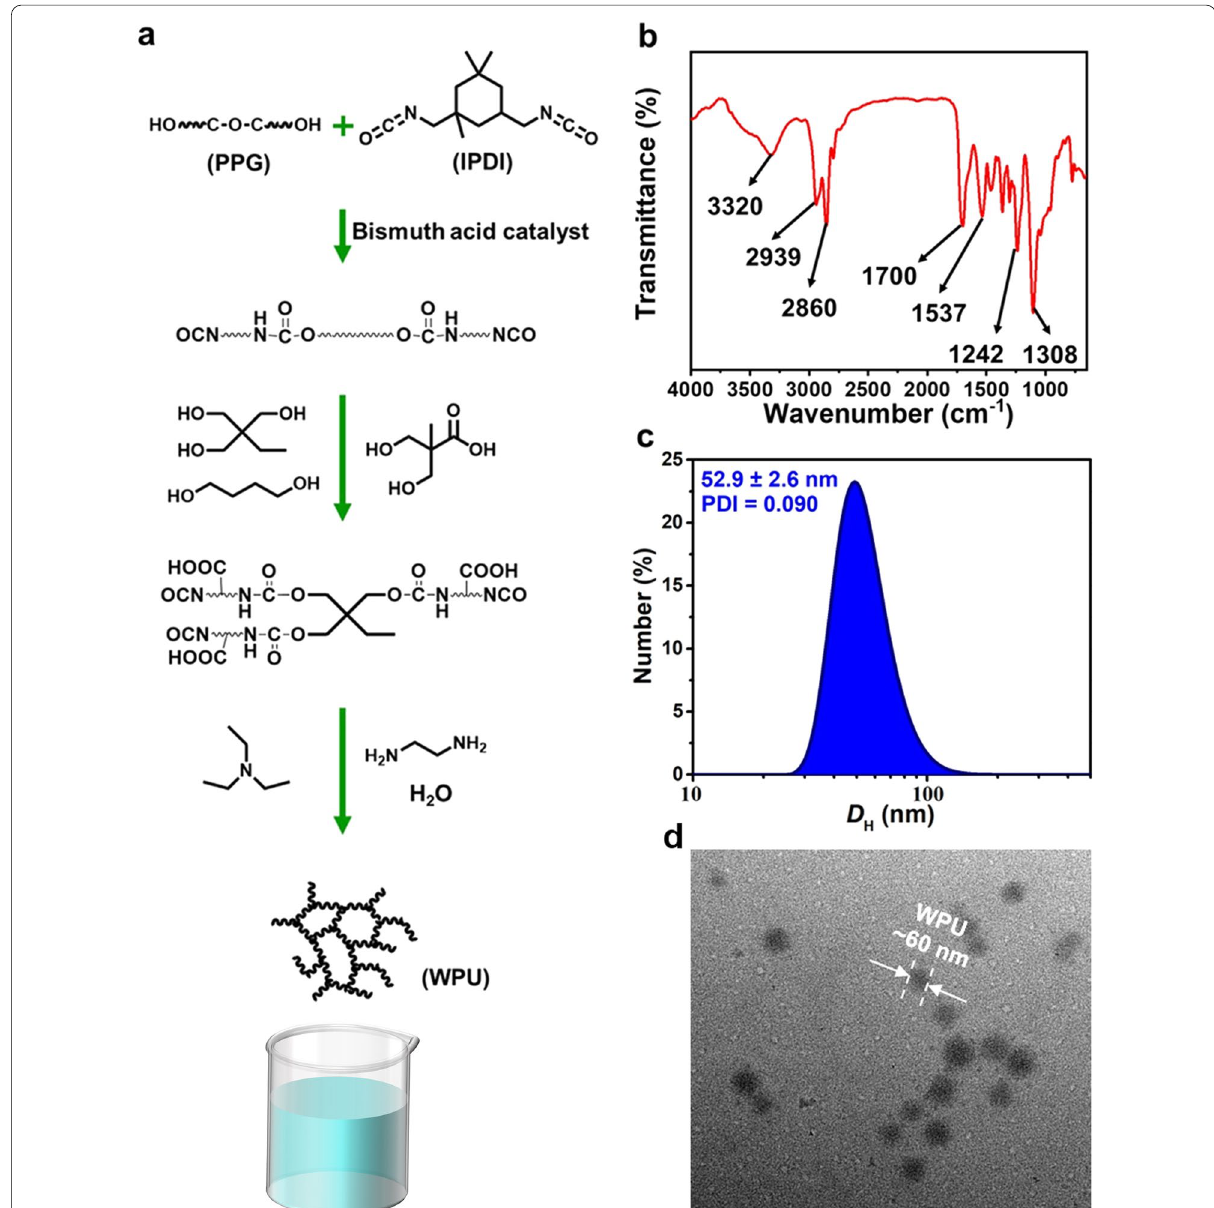
Fig. 3 a The synthetic route of WPU. b The ATR-FTIR spectrum of WPU. c The size distribution as revealed by DLS for WPU in H 2 O. d TEM image of